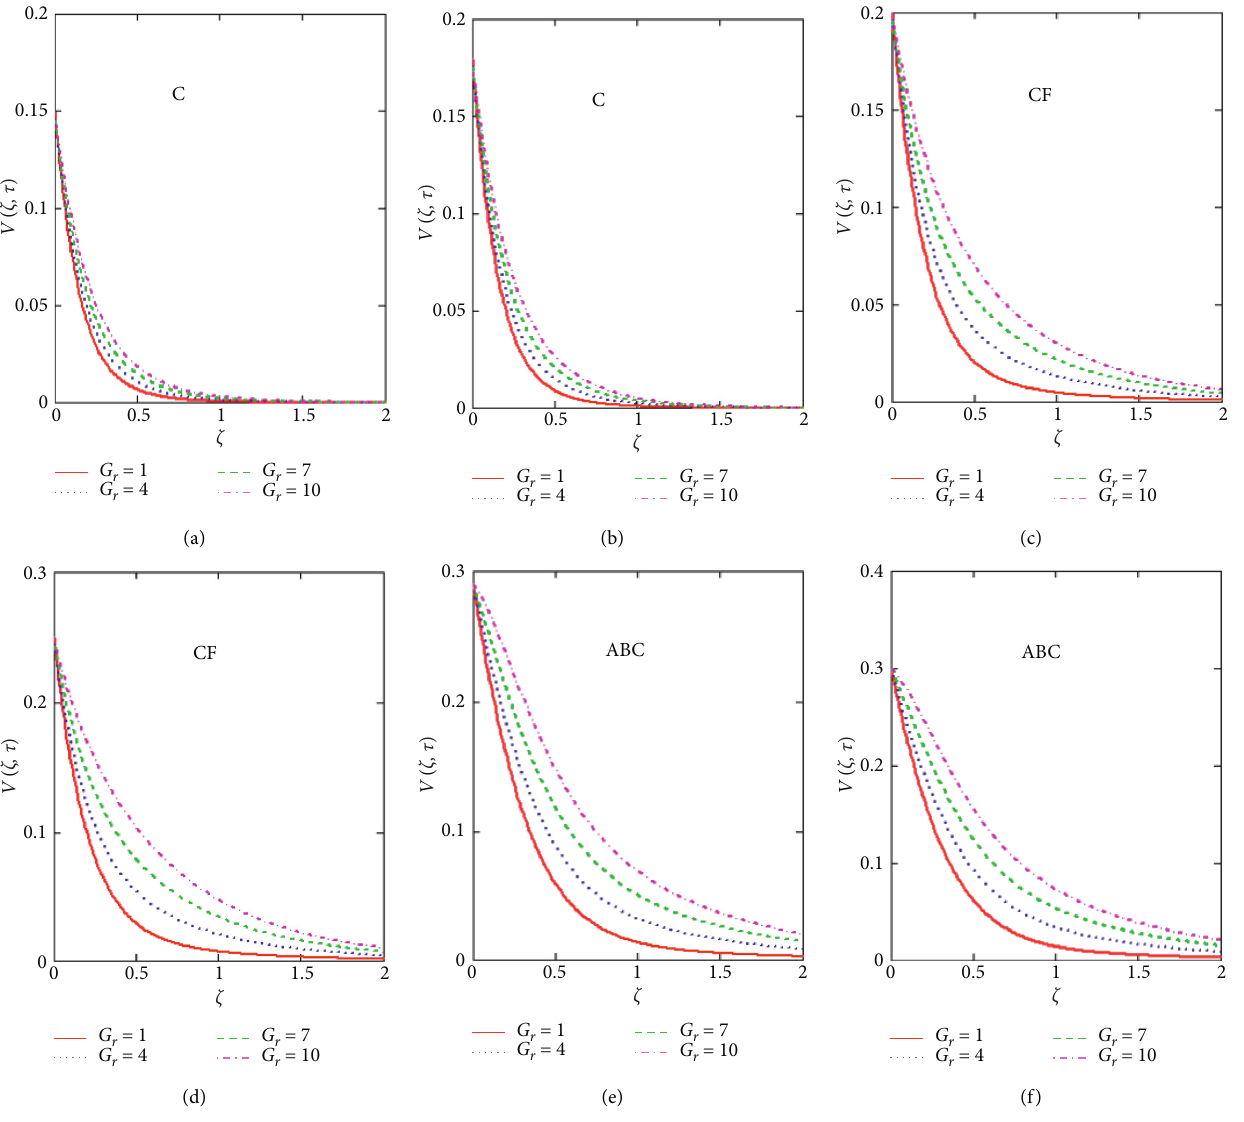
Figure 5: Plot via C, CF, and AB approaches for velocity with different values of G